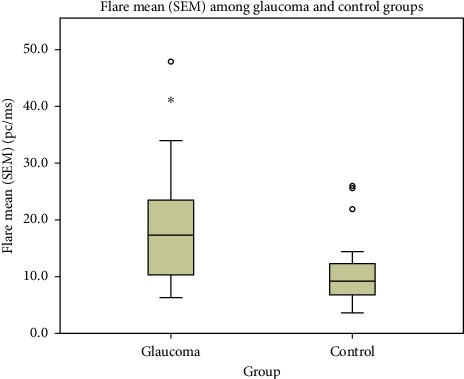
The graph shows aqueous humour flare mean (SEM) among glaucoma and control groups. The glaucoma group showed significantly higher aqueous humour flare than that of the control group (p < 0.001, Mann–Whitney U test). PEX syndrome and aqueous humour flare.